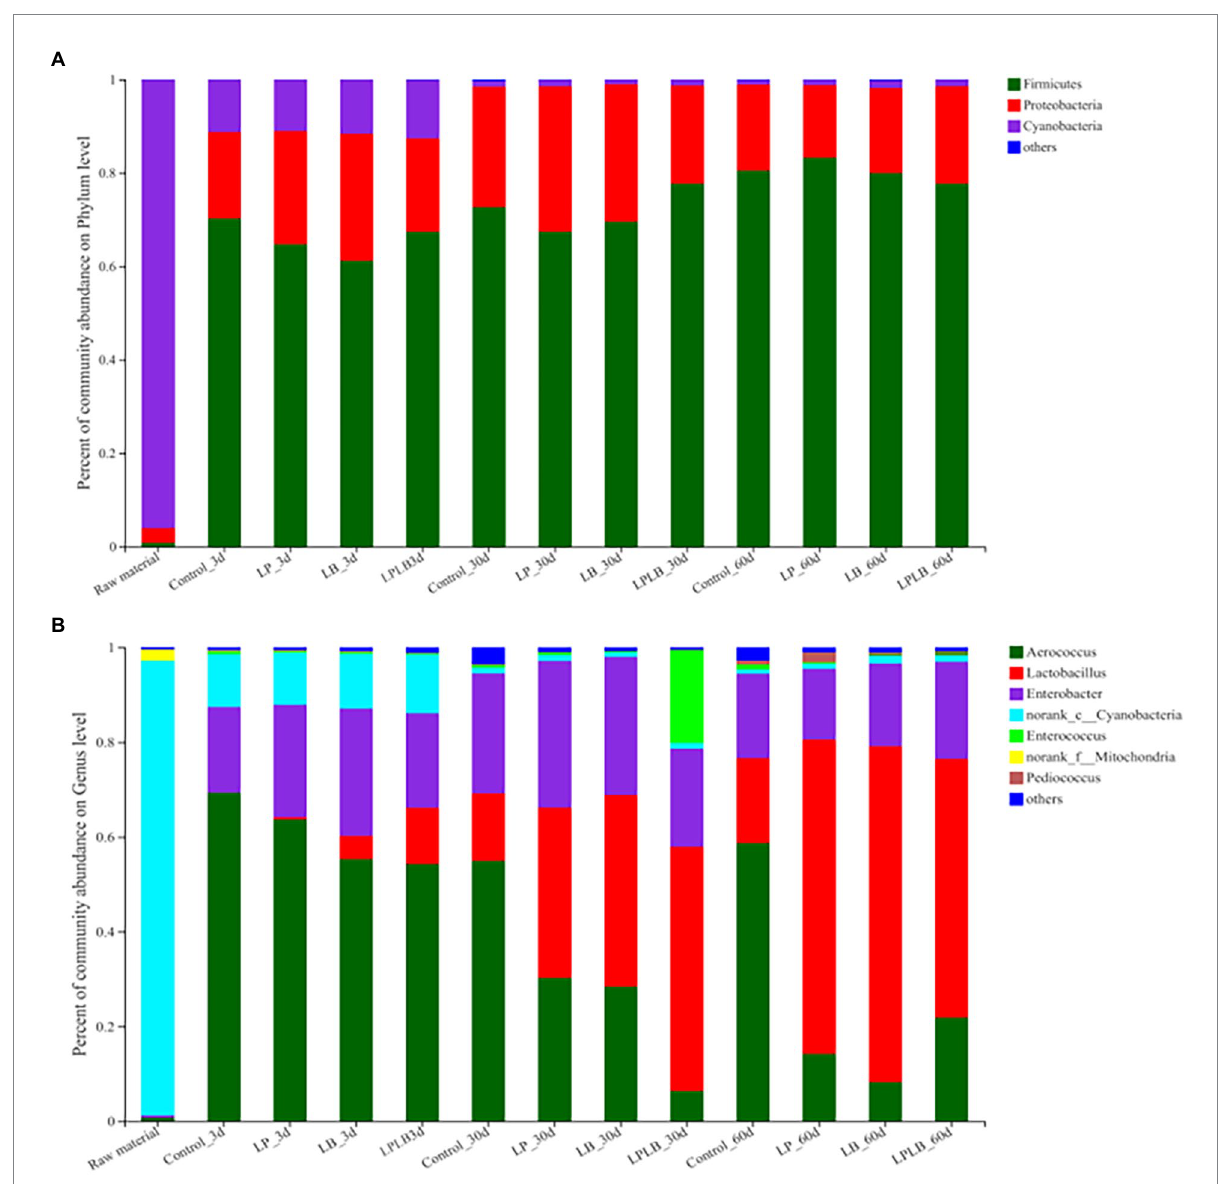
FIGURE 3 Bacterial community and relative abundances by phylum (A) and genus (B) for paper mulberry silage. Control, ensiling with no inoculant applied; LP, inoculated with Lactiplantibacillus plantarum ; LB, inoculated with Lactiplantibacillus brevis ; LPLB, inoculated with L. plantarum and L. brevis